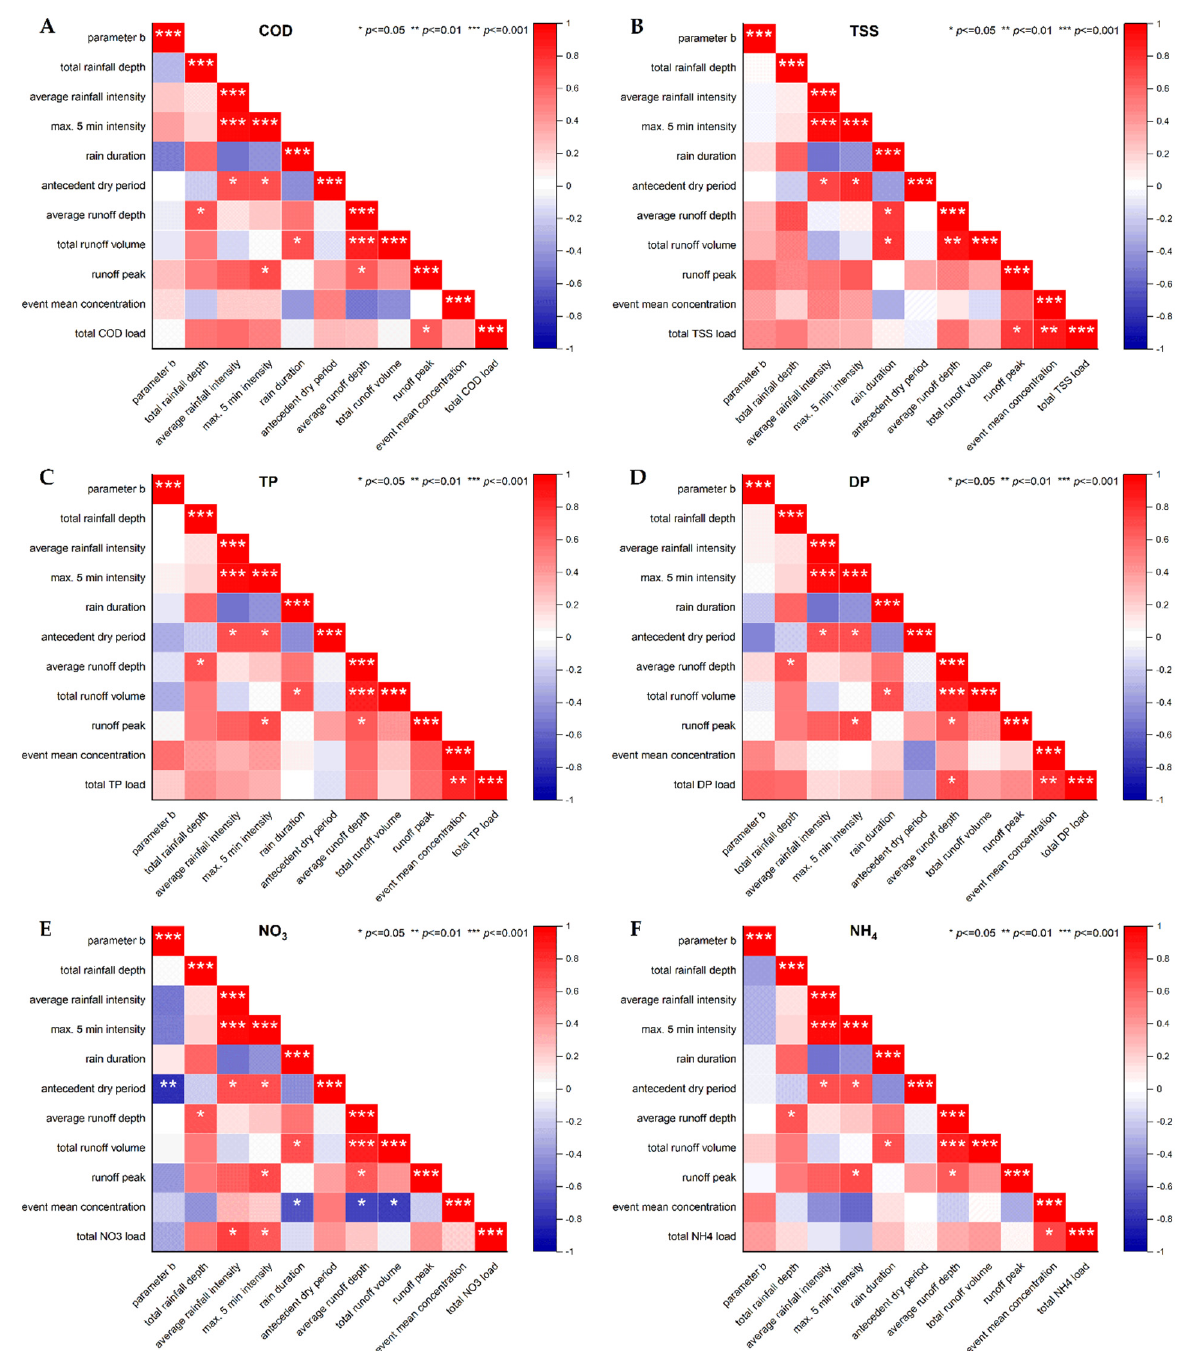
Figure 3. Correlation pattern for investigated pollutants COD ( A ), TSS ( B ), total P ( C ), dissolved P ( D ), NO 3 ( E ) and NH 4 ( F ) with level of significance * = p ≤ 0.05, ** = p ≤ 0.01 and *** = p ≤ 0.001. Red squares indicating a positive, blue squares indicating a negative correlation coefficient.